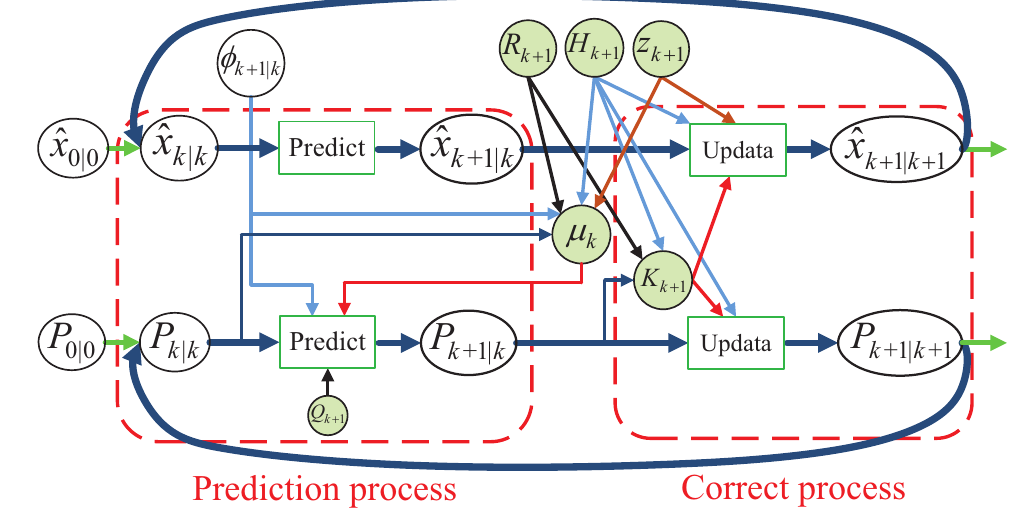
Figure 3. The operation of the AEKF algorithm.